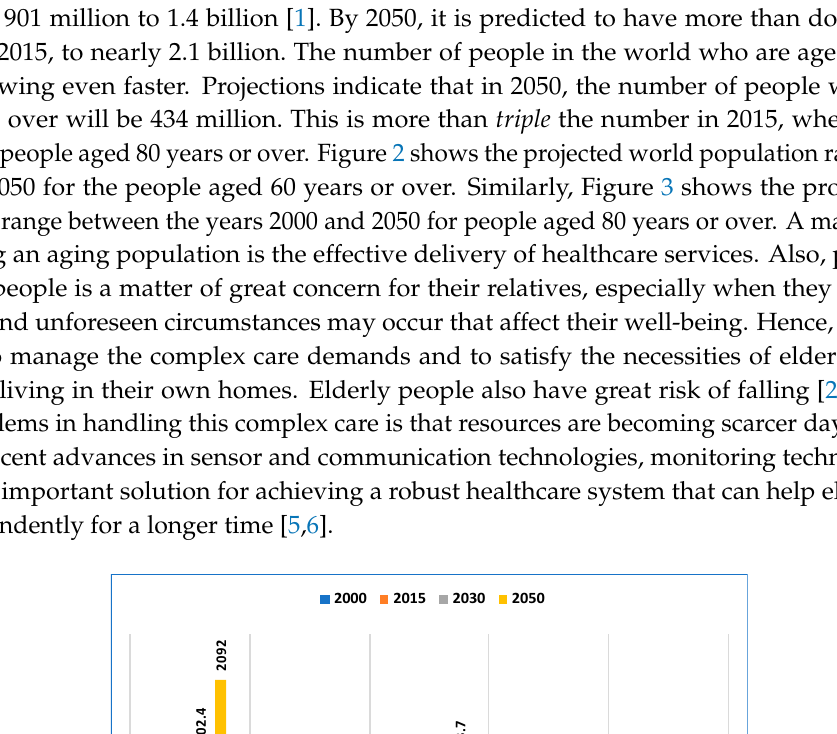
Figure 2. Numbers of persons (millions) aged over 60 years in the world in different years [1].